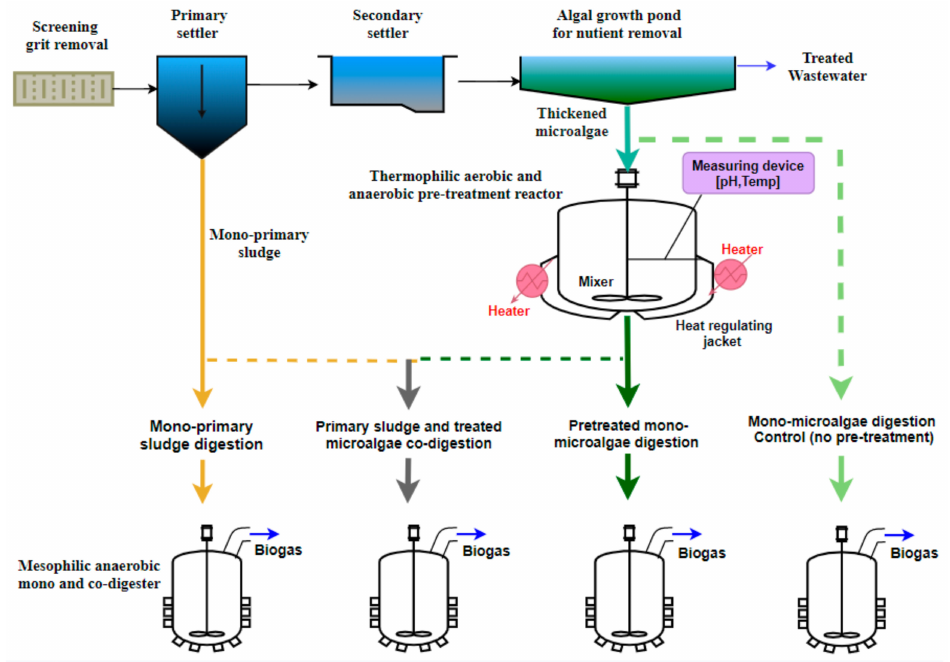
Figure 1. Schematic configuration of substrate source and lab-scale alignments of anaerobic digestion process with and without biological